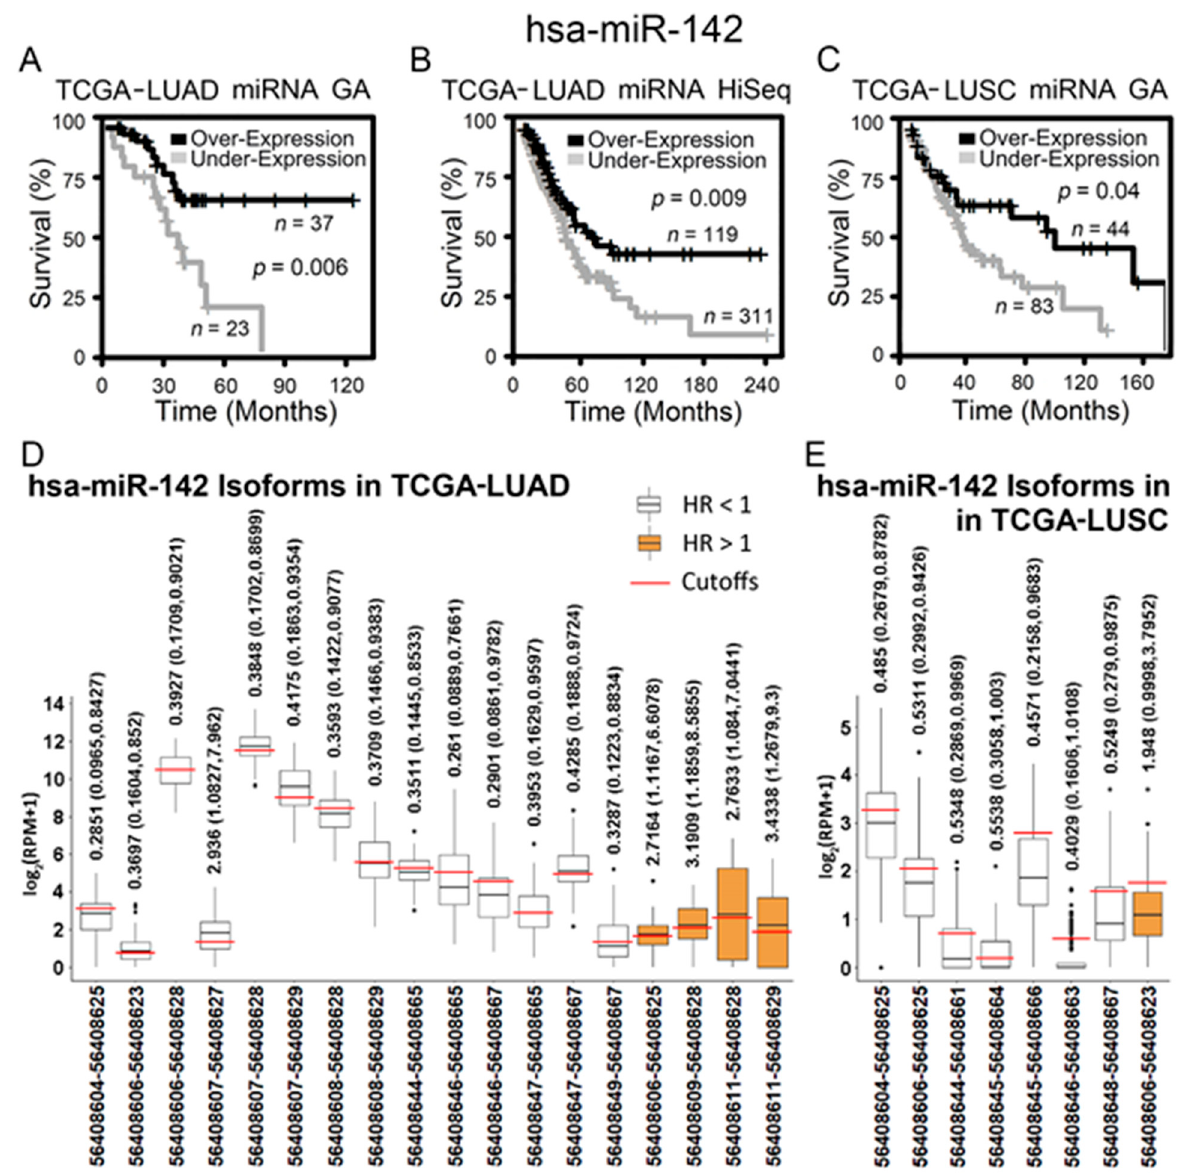
Figure 3. RNA-sequencing data of hsa-miR-142 and its isoforms in The Cancer Genome Atlas lung adenocarcinoma (TCGA-LUAD) and lung squamous cell carcinoma (TCGA-LUSC) patient cohorts. ( A – C ) Kaplan–Meier analysis of patient tumors grouped by hsa-miR-142 differential expression in TCGA-LUAD and TCGA-LUSC. When hsa-miR-142 was overexpressed, patients survived for a significantly longer period of time. The cutoff points of hsa-miR-142 overexpression and underexpression were: ( A ) miRNA cutoff = 12.5 in TCGA-LUAD GenomeAnalyzer (GA), ( B ) miRNA cutoff = 11.7 in TCGA-LUAD HiSeq, and ( C ) miRNA cutoff = 13.1 in TCGA-LUSC GenomeAnalyzer (GA). ( D , E ) The expression of hsa-miR-142 isoforms (with positions in chromosome 17 according to Human Genome 19 (hg19)) that had a significant hazard ratio (HR) in patient groups of overexpression versus underexpression in TCGA-LUAD ( D ) and TCGA-LUSC ( E ). Each isoform had a specific expression cutoff point to generate the corresponding HR shown in the figure.